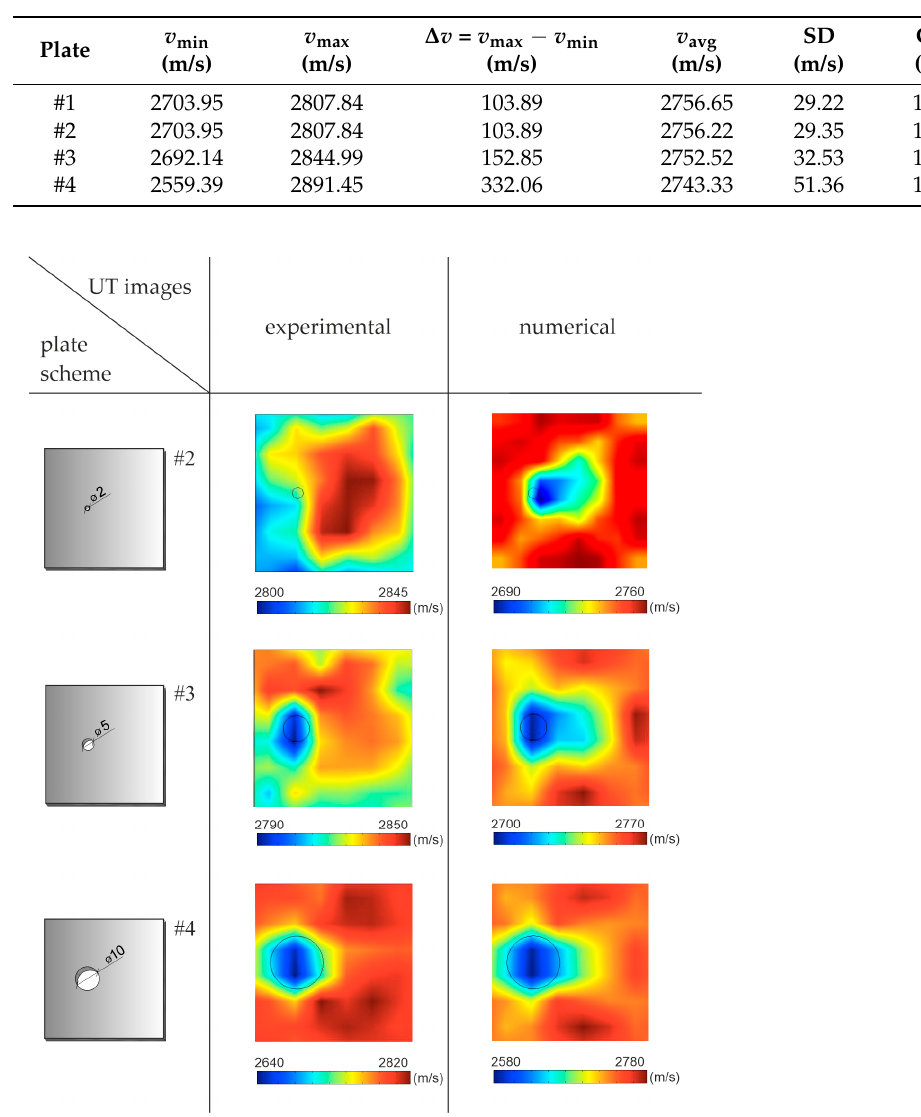
Table 1. Wave propagation velocities in steel plates for data from experimental tests.